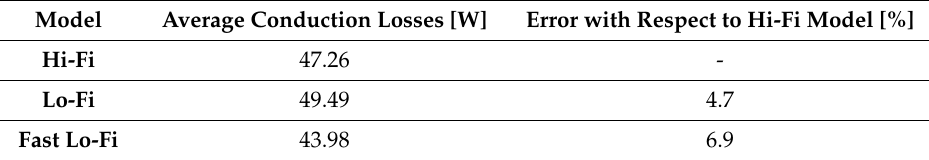
Table 4. Average conduction power losses in Hi-Fi, Lo-Fi, and Fast Lo-Fi models.